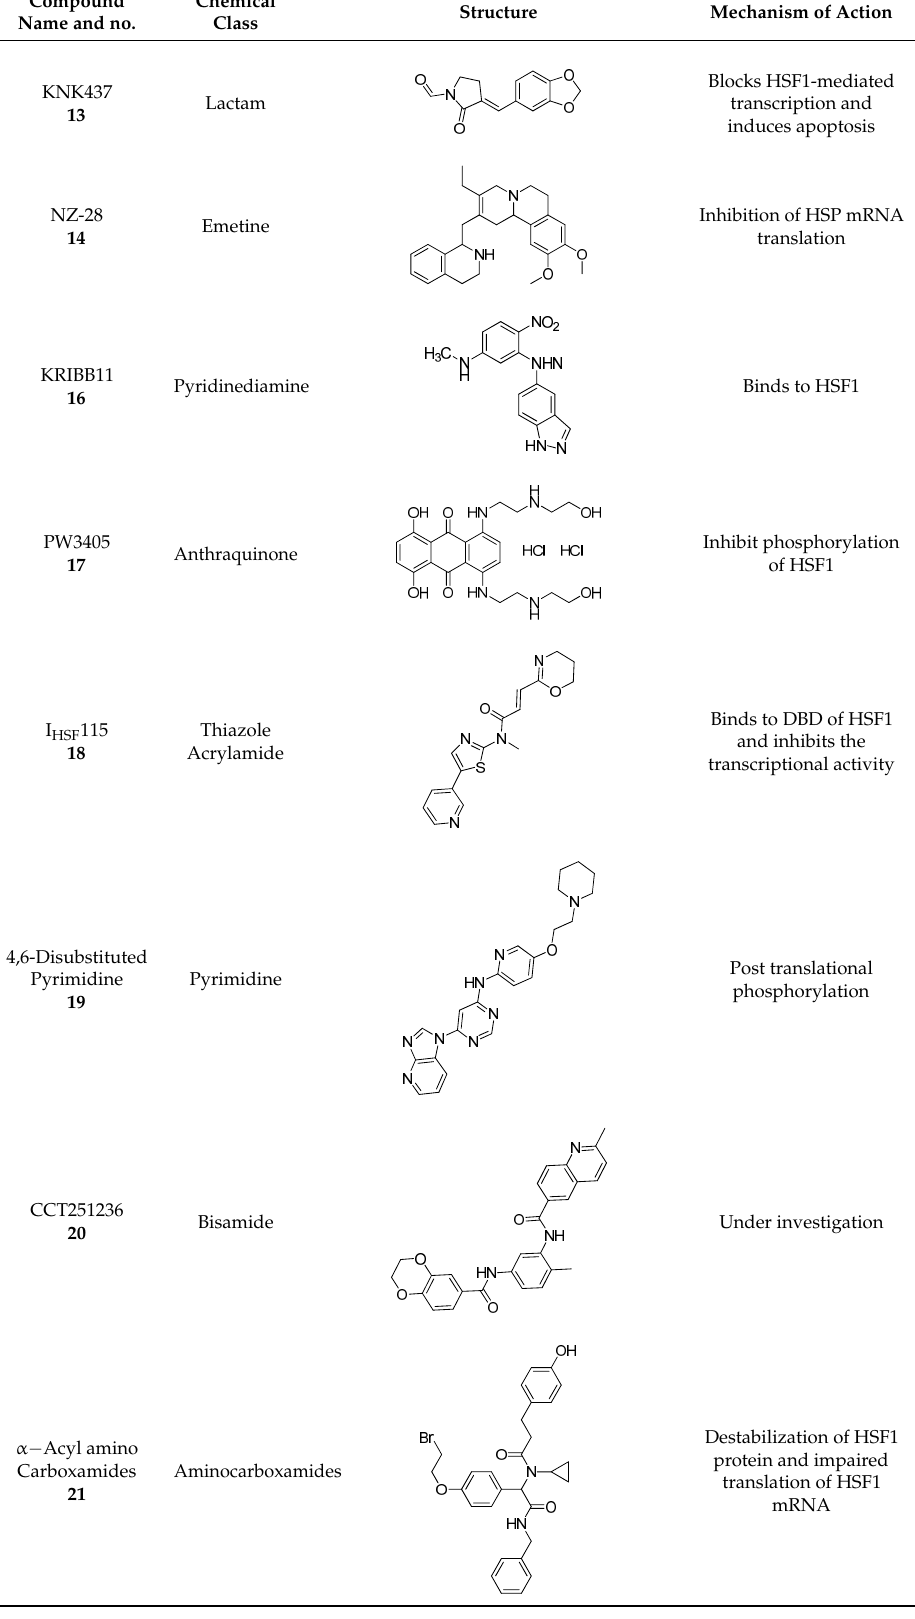
Table 3. List of synthetic HSF1 inhibitors.